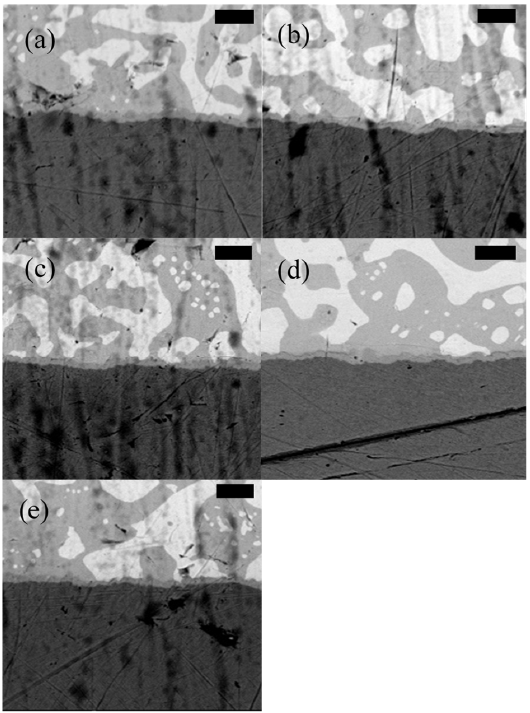
Figure 11. SEM images of LT 47 reflowed with ( a ) a peak temperature of 165 °C and 45 s TAL, ( b ) peak temperature of 165 °C and 90 s TAL, ( c ) peak temperature of 177 °C and 45 s TAL, ( d ) peak temperature of 177 °C and 90 s TAL and ( e ) peak temperature of 190 °C and 90 s TAL. The scale bar is 4 µm in all images.